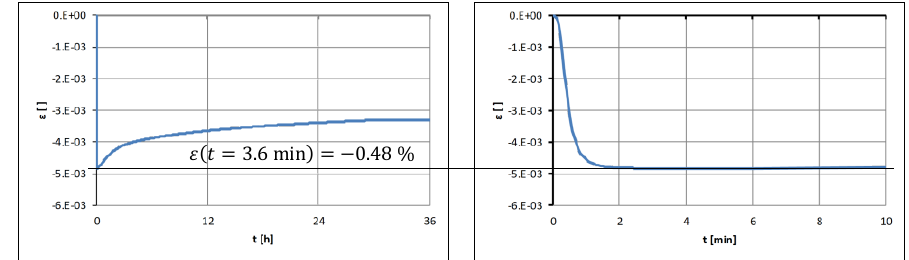
Fig. 12 Expansion of the edge bond over time.